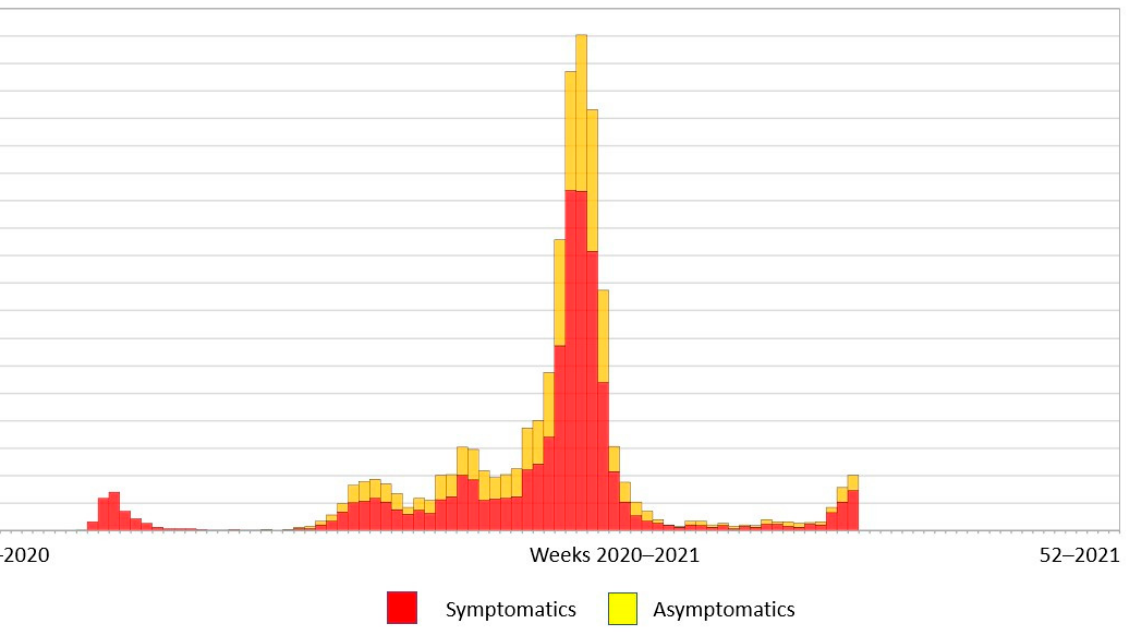
Figure 1. COVID-19 incidence in the Health Department of Alicante–Hospital General in 2020 and 2021. The 14-day COVID-19 incidence rose above 250 cases/100,000 inhabitants within 23 weeks, and above 500 cases/100,000 inhabitants within 8 weeks.